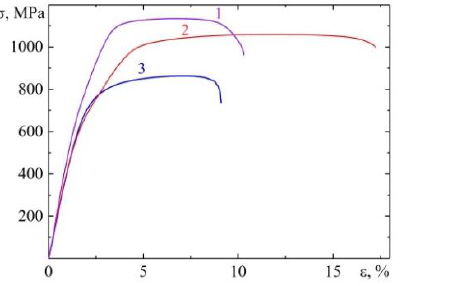
Fig. 6. Tensile engineering stress–strain curves for the SLM-(1), EBM-(2) and EBF 3 -fabricated Ti– 6Al–4V samples (3)